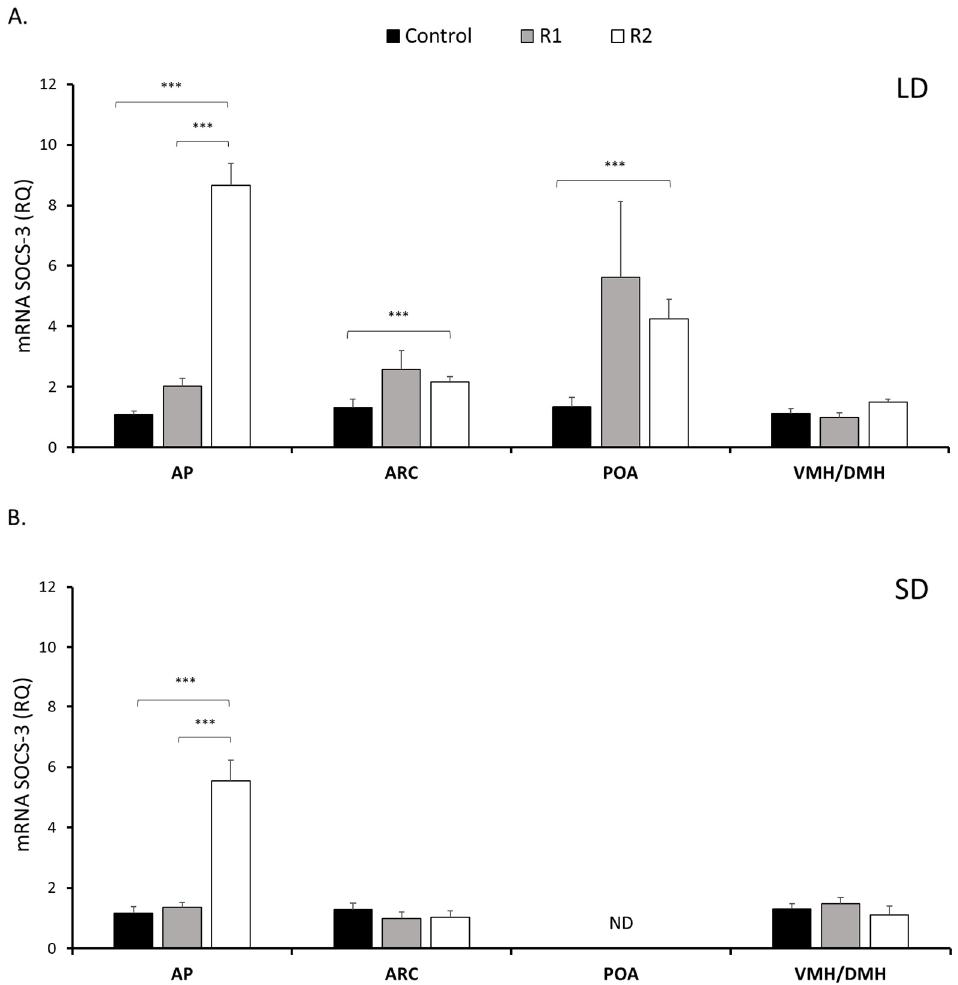
Figure 4. Expression of SOCS-3. The mean expression ( ± SEM) of a suppressor of cytokine signaling-3 (SOCS-3) mRNA in the ovine anterior pituitary (AP), arcuate nucleus (ARC), preoptic area (POA) and ventro- and dorsomedial nuclei (VMH / DMH) collected during long-day (LD) (panel A) and short-day (SD) (panel B) photoperiods. The expression of SOCS-3 mRNA is reported in arbitrary units (RQ) relative to cyclophilin mRNA and expressed relative to the calibrator sample. Di ff erences relative to the control or between the other groups are indicated with *** P < 0.001. Samples in which the expression of the target gene was undetectable are designated with ND.